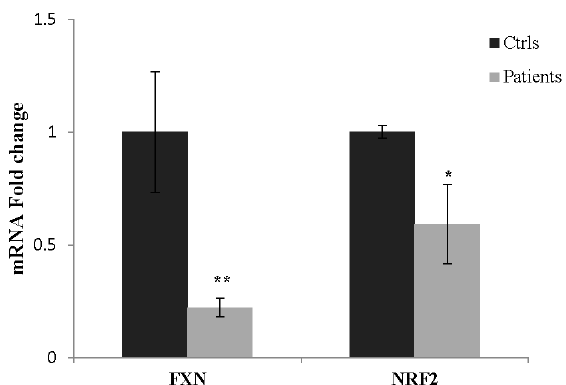
Figure 7. Frataxin and NRF2 mRNA levels in blood of patients with FA. qRT-PCR performed on PBMCs isolated from blood of FA patients ( n = 4) evidenced 35% and 59% residual amounts of Fxn and NRF2 expression, respectively, compared with healthy subjects ( n = 5) (* p < 0.05,** p < 0.01, respect to healthy subjects).